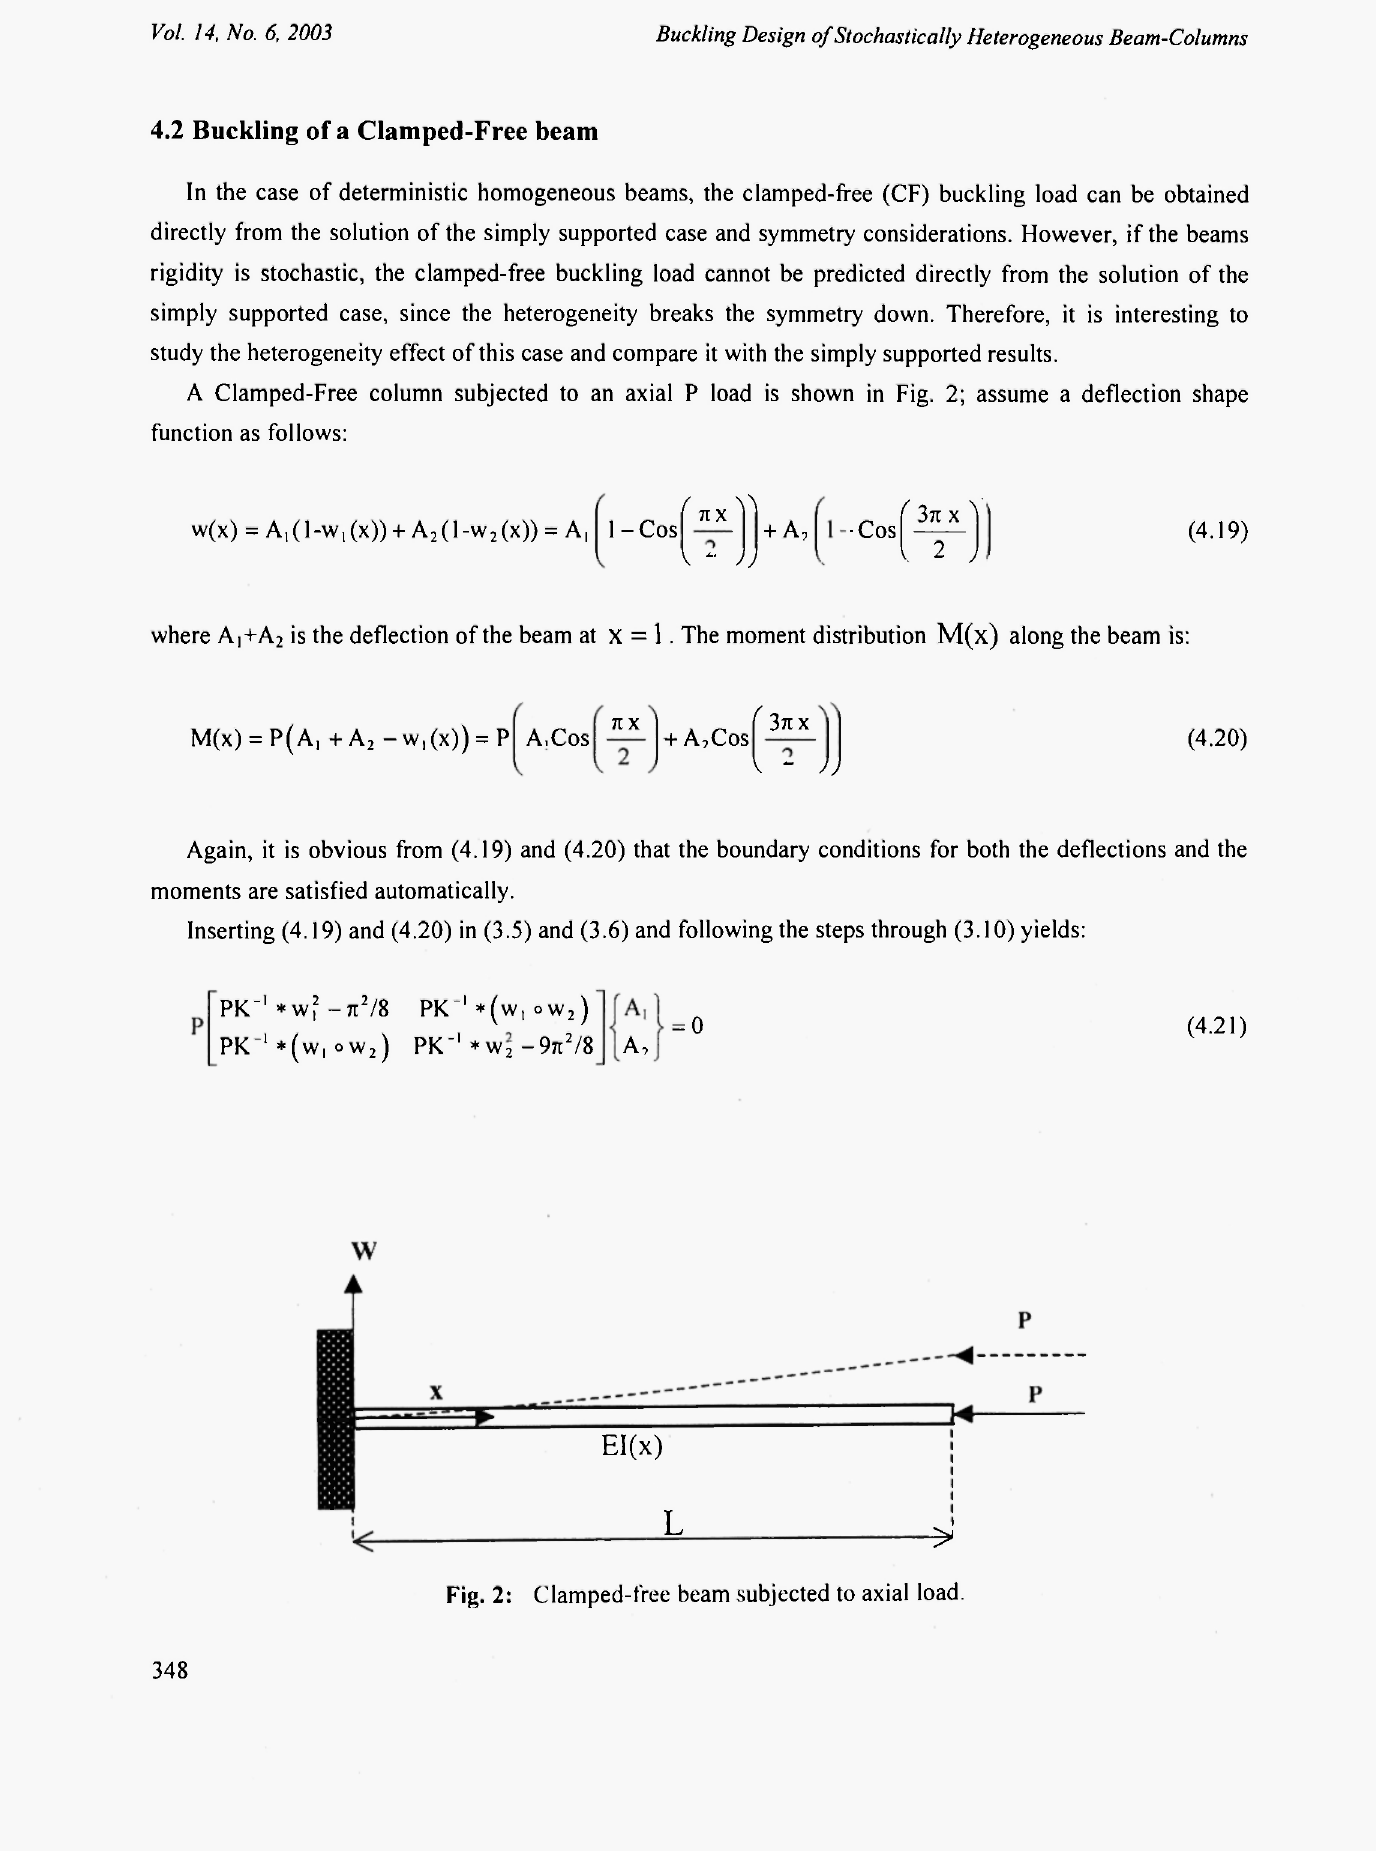
Fig. 2: Clamped-free beam subjected to axial